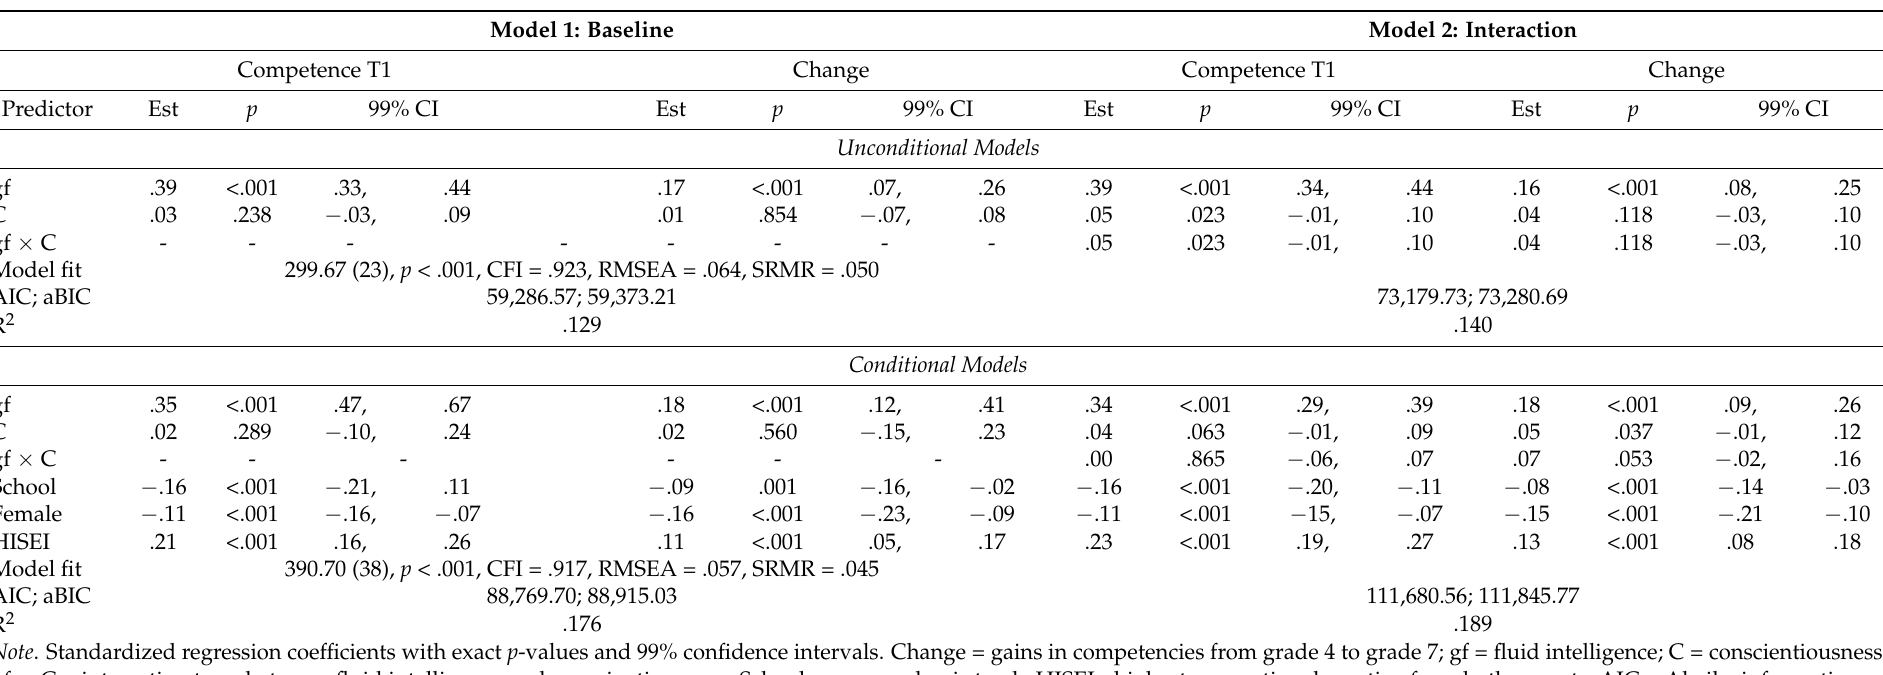
Table 6. Latent change score models predicting mathematic competence baseline levels and gains in